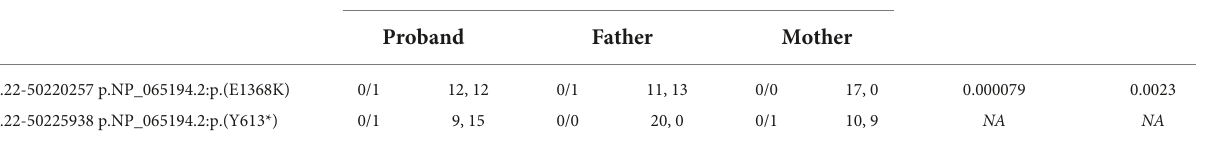
TABLE 1 Variants’ locations, genotype, numbers of supporting reads, and allele frequencies (AF) in global population and East Asian population (EA) for TUBGCP6 . Position Genotype and supporting reads Global AF AF in EA Proband Father